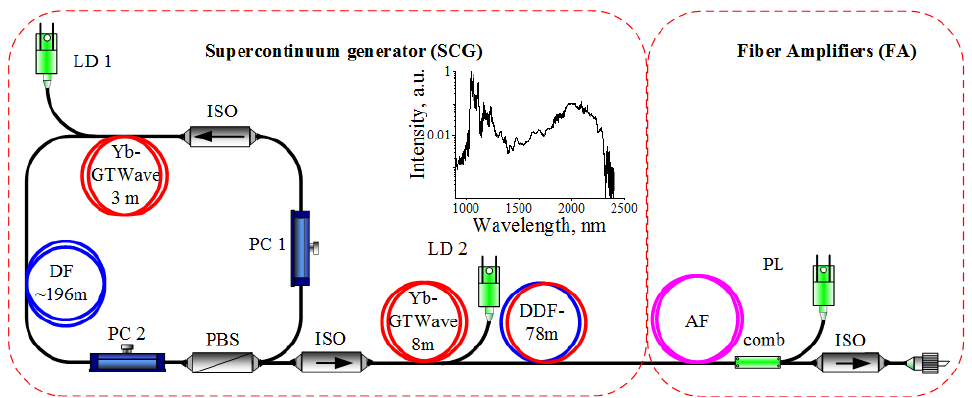
Figure 1. Experimental setup. SCG: ISO-optical isolator, LD 1,2-pump laser diodes, PC 1,2-polariza- tion controllers, DF-delay fiber, PBS-polarization beam splitter, DDF-dispersion decreasing fiber. FA: AF—active fiber (Er-, Tm, or Ho-doped), PL—pump laser (976, 793, or 1130 nm depending on REE), comb-pump combiner.